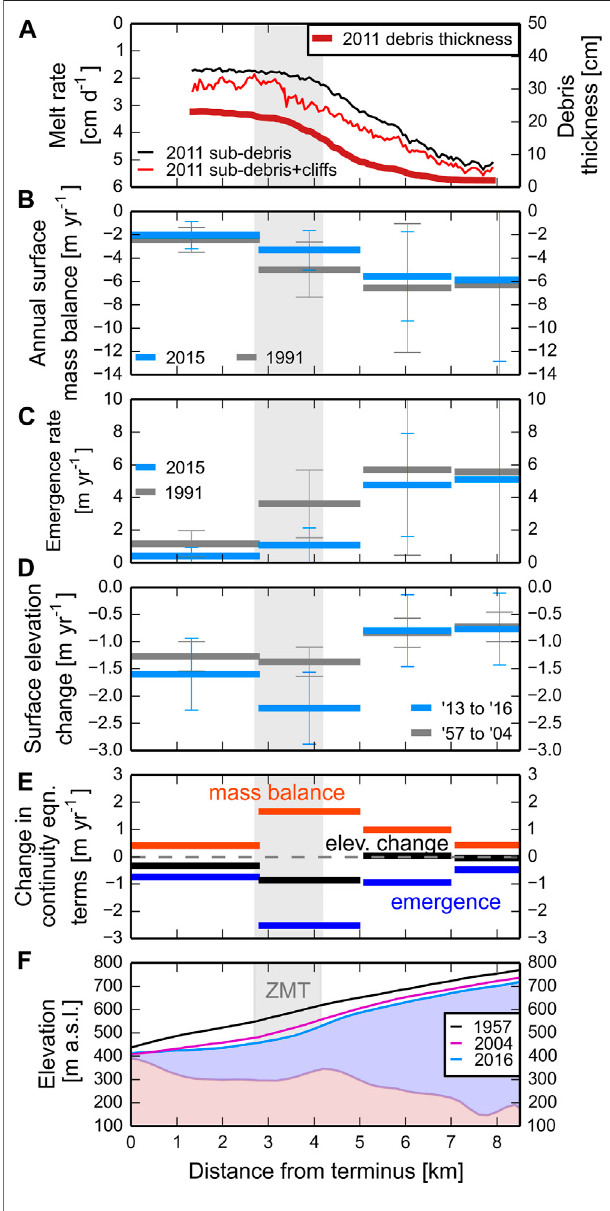
FIGURE 3 | Changes in ice continuity equation terms over multiple decades. The zone of maximum thinning (ZMT) is shown with grey shading. (A) Debris thickness with distance from the terminus for the 5 central medial moraines (Anderson et al., 2021). Distributed melt rate estimates from Anderson et al. (2021). (B) Annual surface mass balance based on 2015 annual velocities and thinning between 2013 and 2016. As well as the annual surface mass balance based on 1991 annual velocities and thinning between 1957 and 2004. (C) The change in ice emergence rate in time. (D) Glacier surface elevation change from 1957 to 2004 and from 2013 to 2016. (E) The change in the terms of the continuity equation between 1991 and 2015. The bars represent the difference between the bars in each of panels B, C, and D. (F) Surface pro fi les through time and the bed pro fi le of Kennicott